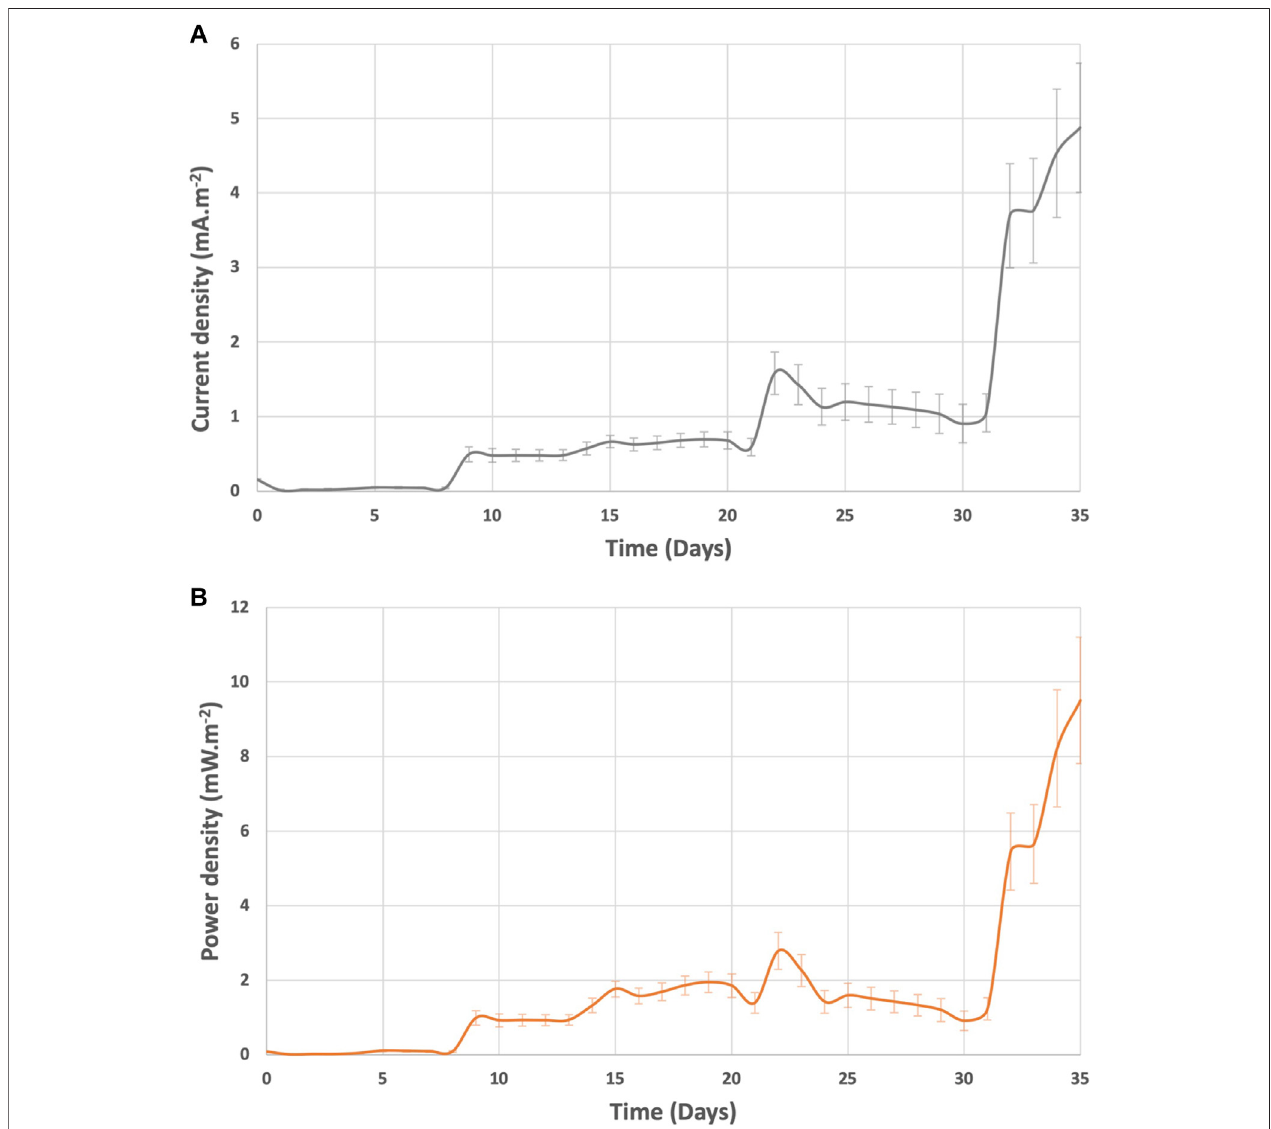
FIGURE 4 | (A) current density and (B) power density recorded during batch